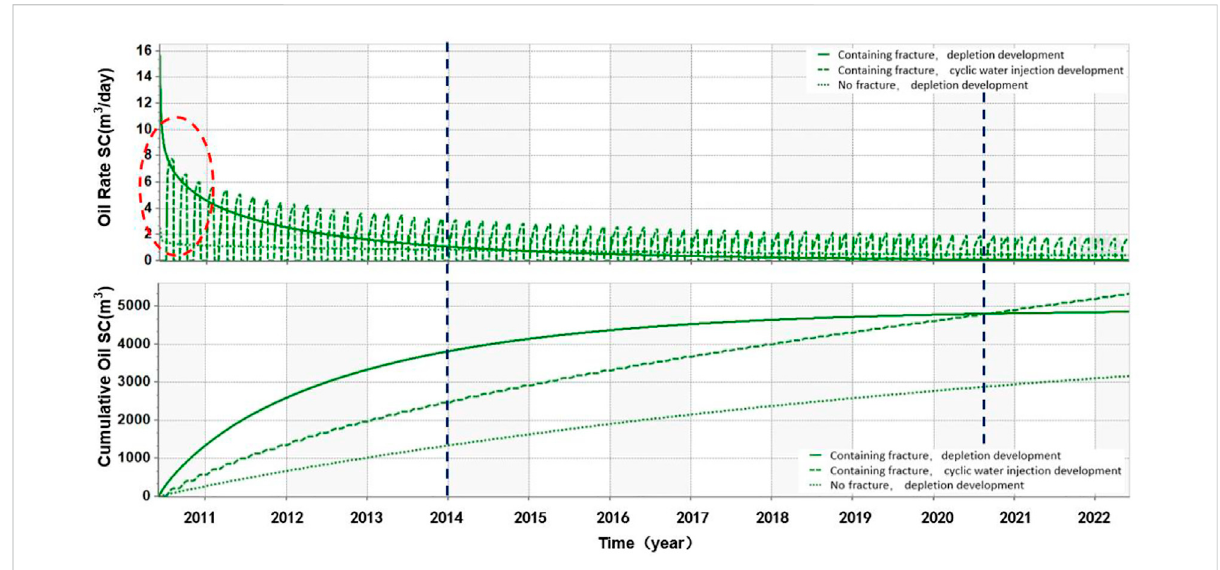
FIGURE 5 Daily and cumulative oil production curves for well W under different development methods.